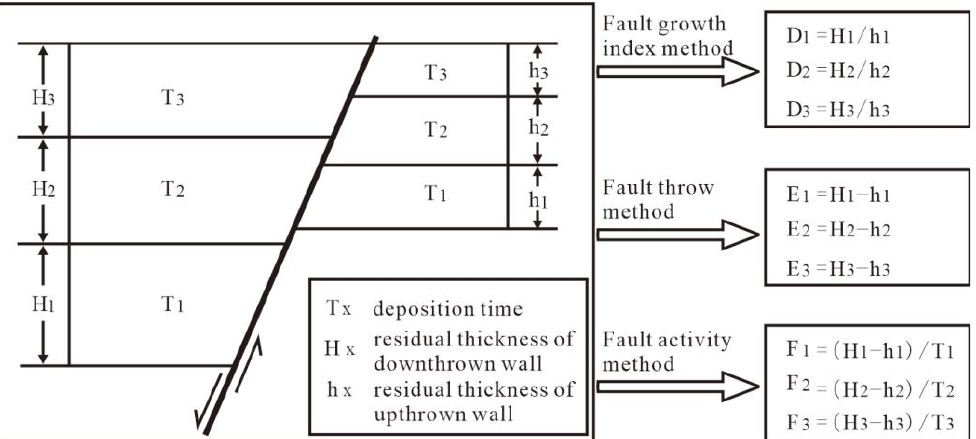
Figure 3. Three methods for analyzing the fault activity (Modified after Jiang et al., 2009 [32]).